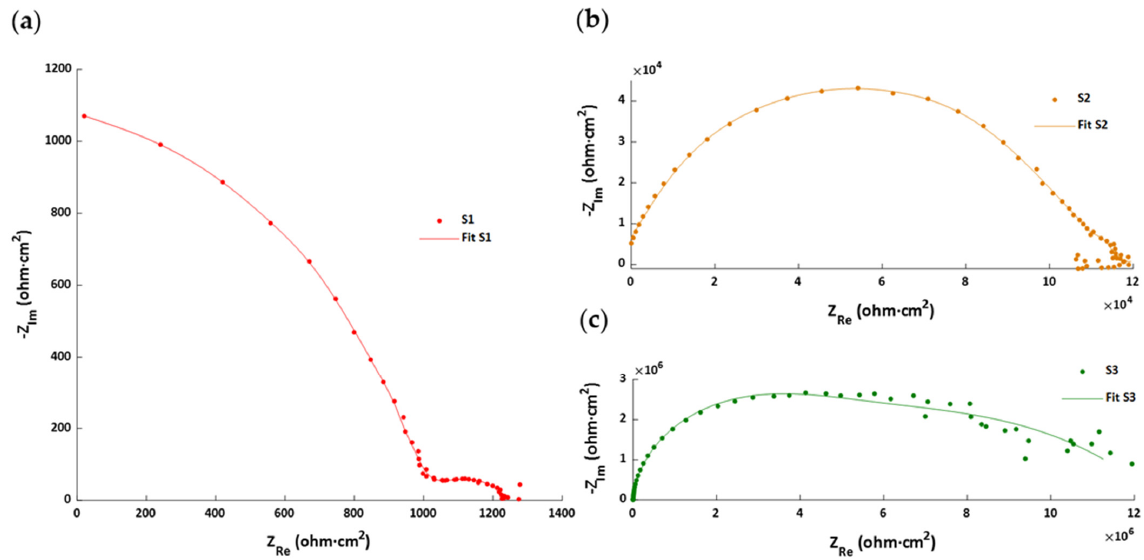
Figure 16. Bode diagrams corresponding to the S1–S5 samples: ( a ) modulus and ( b ) frequencies as well as those corresponding to the S1G–S5G samples: ( c ) modulus and ( d ) frequencies.